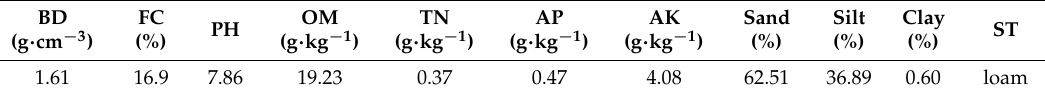
Table 1. Physical and chemical properties of cinnamon soil. BD for Bulk density; FC for field capacity; OM for organic matter; TN for total N; AP for available P; AK for available K; ST for soil